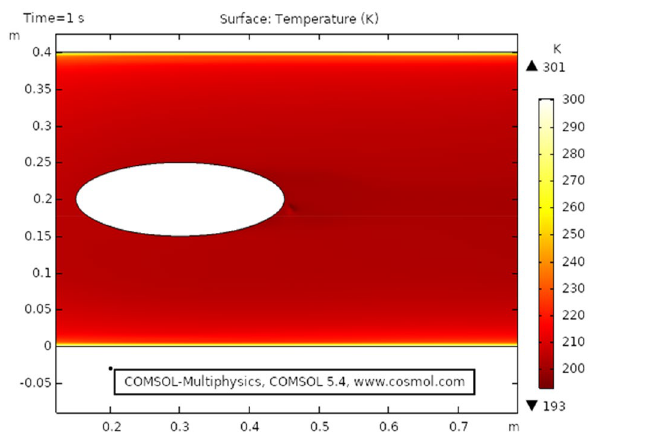
Figure 10. Temperature distribution at t = 1 s .